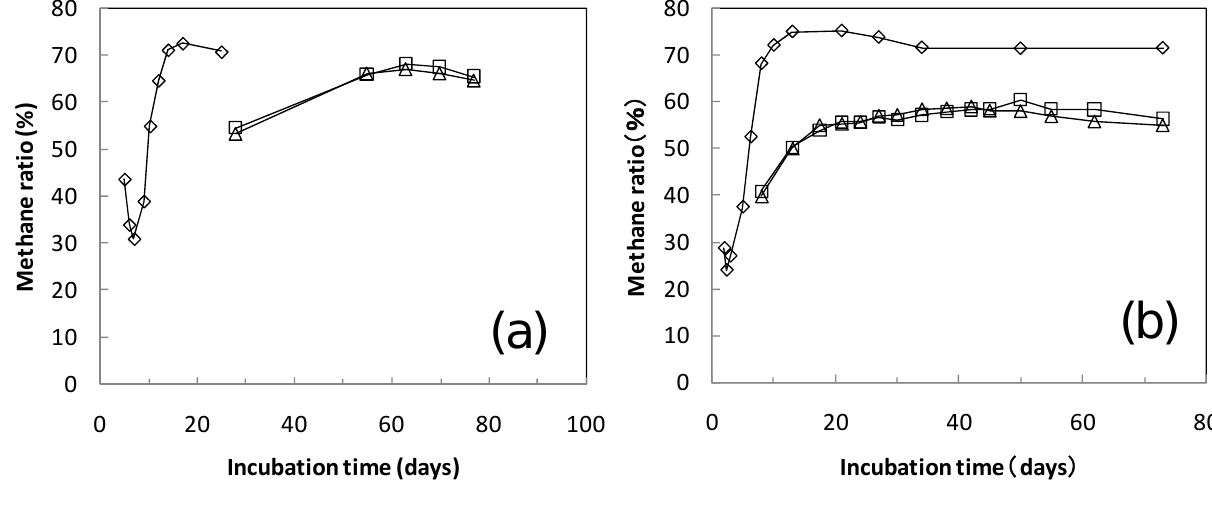
Figure 6. Methane ratio in PLA anaerobic biodegradation test. The test vessels were incubated at 35  C (a) and 55  C (b). ◊ ; cellulose 10g, ∆ , □ ; PLA